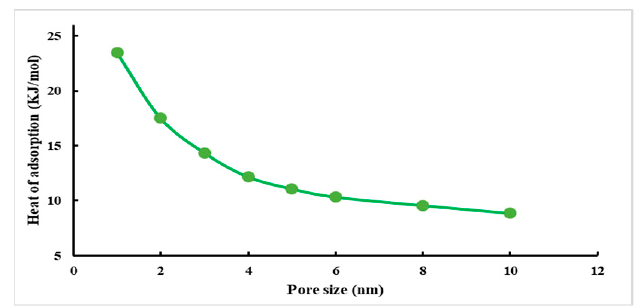
7 of 11 Figure 6. Comparison of the density of methane at different pore sizes. (4)